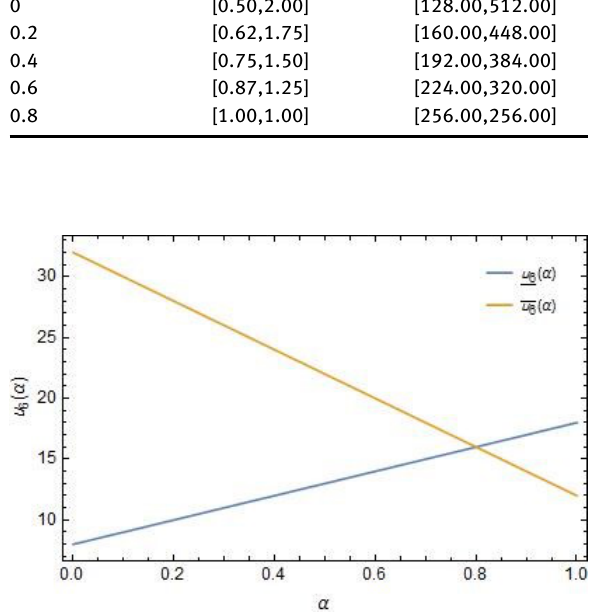
Fig. 5: Solution of u n ( α ) = ⌊ u n ( α ), ¯ u n ( α ) ⌋ for n = 6 of Example 5.2